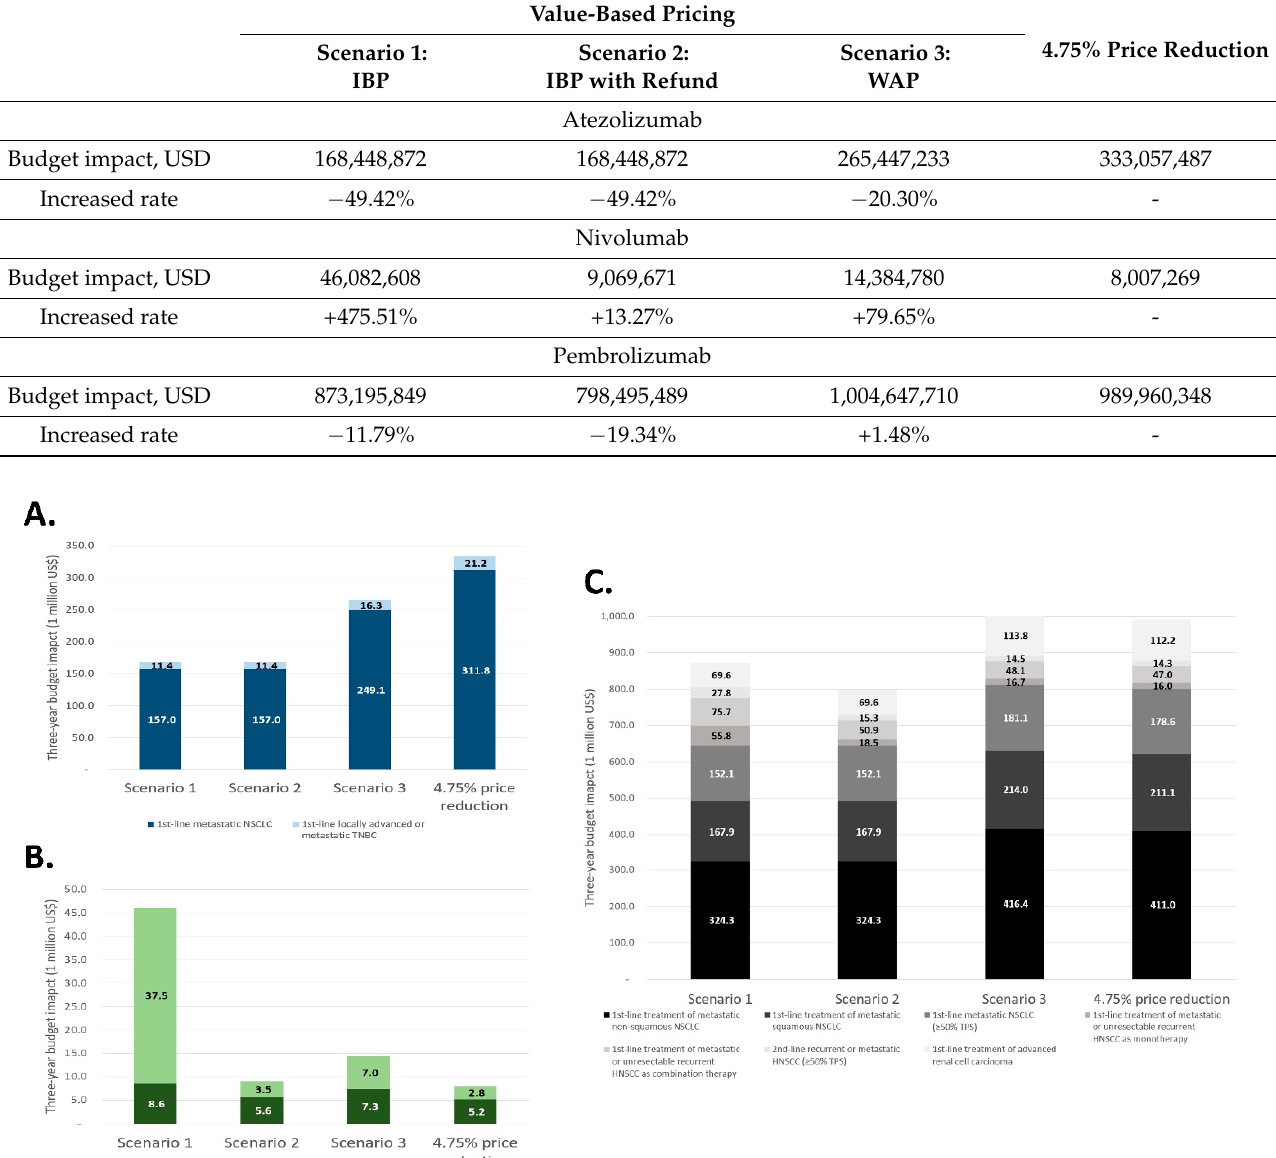
Table 3. The budget impact for non-reimbursed indication of immunotherapies according to each value-based pricing scenario.